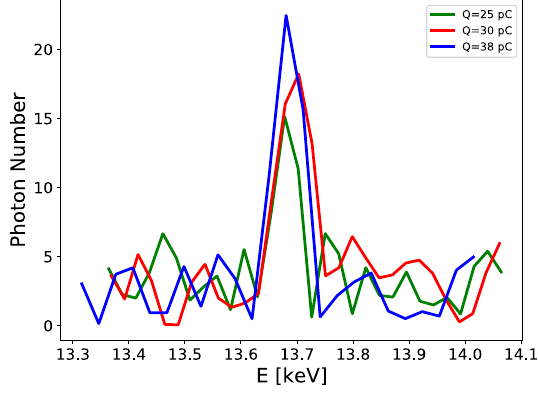
FIG. 5. Shot-to-shot variations of PXR.